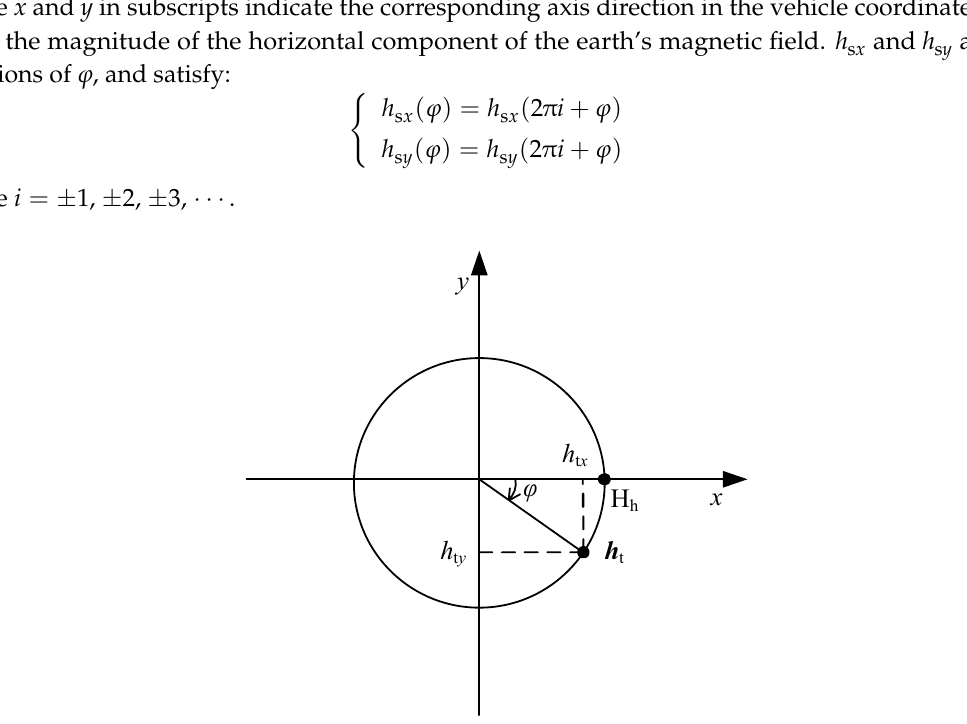
h t and the reference heading ϕ